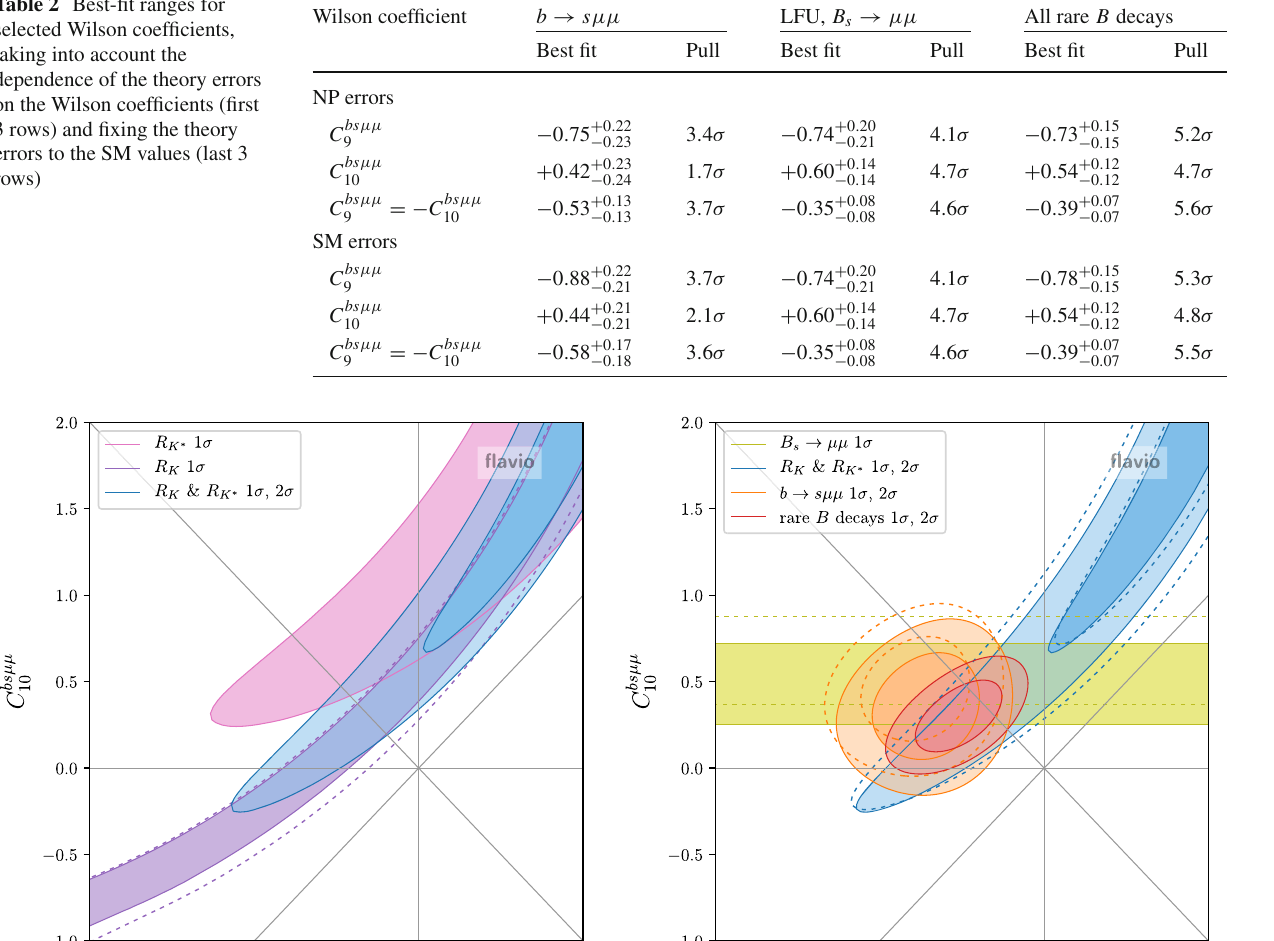
Fig. 4 Constraints in the Wilson coefficient plane C bs b → s μμ observables, BR ( B s → μ + μ − ) , and the global fit. The dashed lines show the constraints before the recent updates